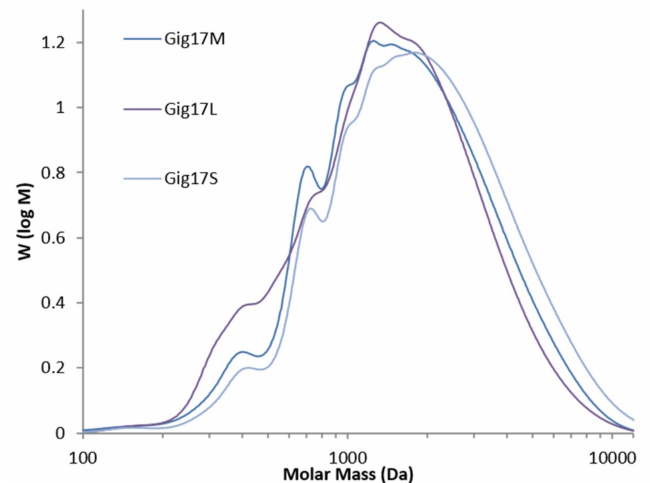
Figure 7. SEC curves of lignins obtained from Miscanthus x giganteus (Mixture: Gig17M. Leaf: Gig17L. Stem